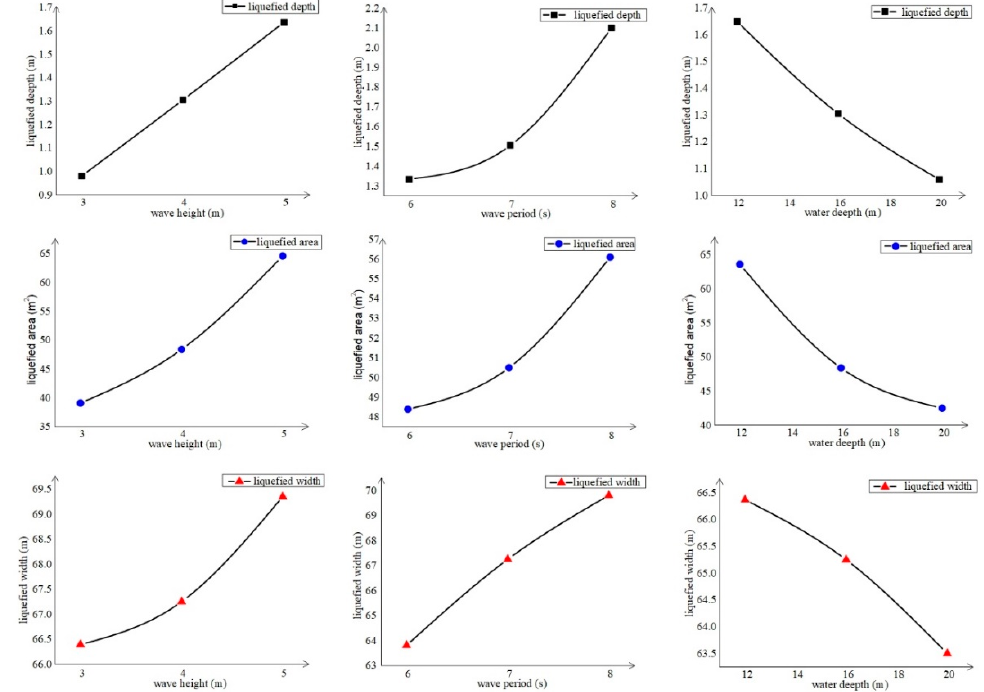
Figure 12. The liquefied conditions around the trench with different wave parameters.